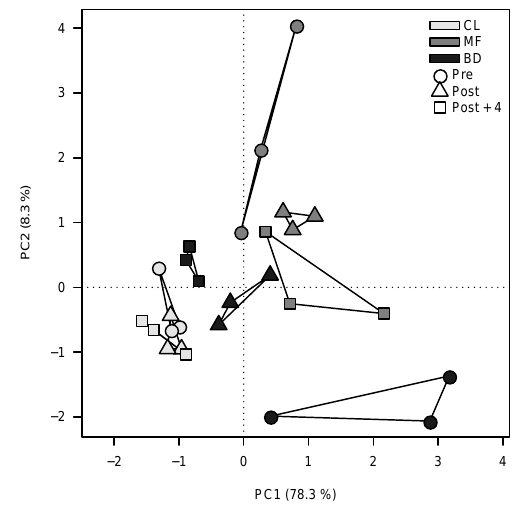
Figure 5. Principal component analysis of mass signals with sig- nificant differences according to Wilks’ λ . Treatments (CL, control; MF, mineral fertiliser; BD, biogas digestate) and sampling times (pre-tillage, post-tillage and post-tillage + 4 days) are depicted by different colours and symbols, respectively. Since the areas inte- grated by the corresponding three sampling points do not overlap for the fertilised treatments, significant distinctions and changes in relative SOM composition can be assumed before and after tillage,